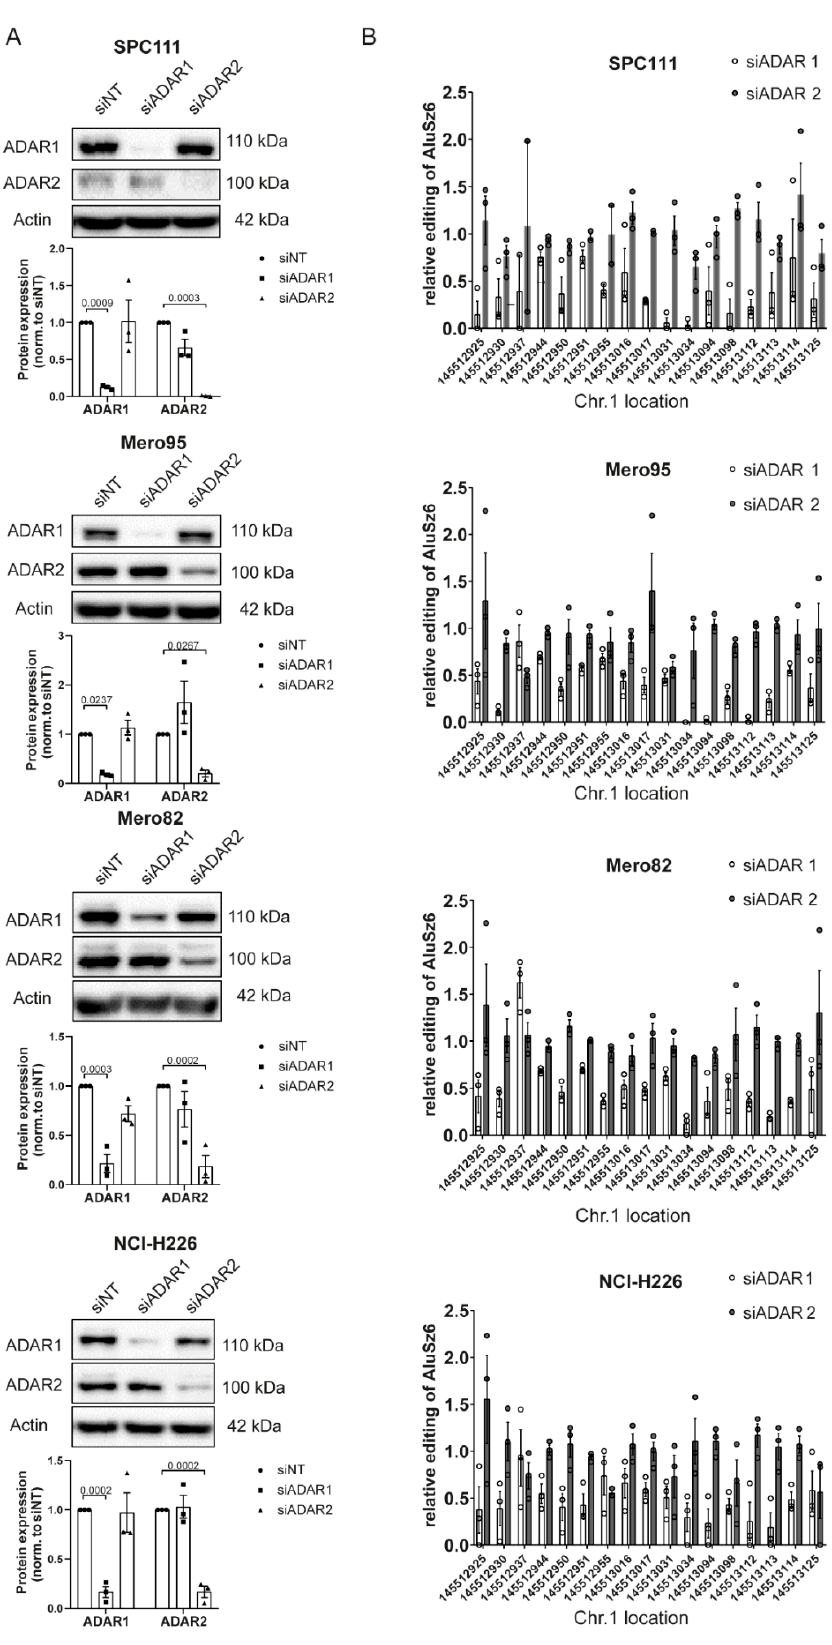
Figure 3. RBM8A editing is dependent on ADAR1 and ADAR2 activity. ( A ) Silencing ADAR1 and ADAR2 genes selectively depletes MPM cells of the corresponding proteins. Tukey’s multiple comparison test. ( B ) The editing rate in AluSZ6 decreases after silencing ADAR1 and ADAR2. Significance is shown in Supplementary Table S3.